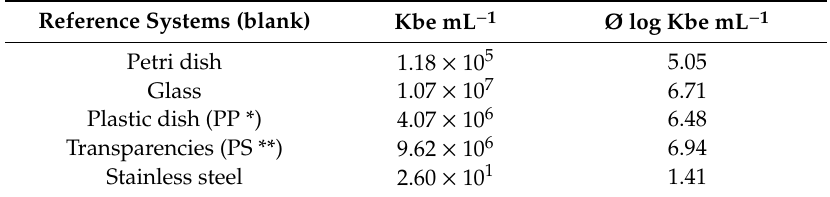
Table 3. Results of antimicrobial activity of di ff erent reference systems surfaces against S. aureus